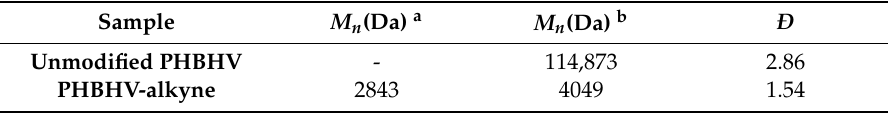
Table 1. Number average molar masses ( Mn ) and dispersity ( Ð ) of unmodified PHBHV and PHBHV-alkyne.